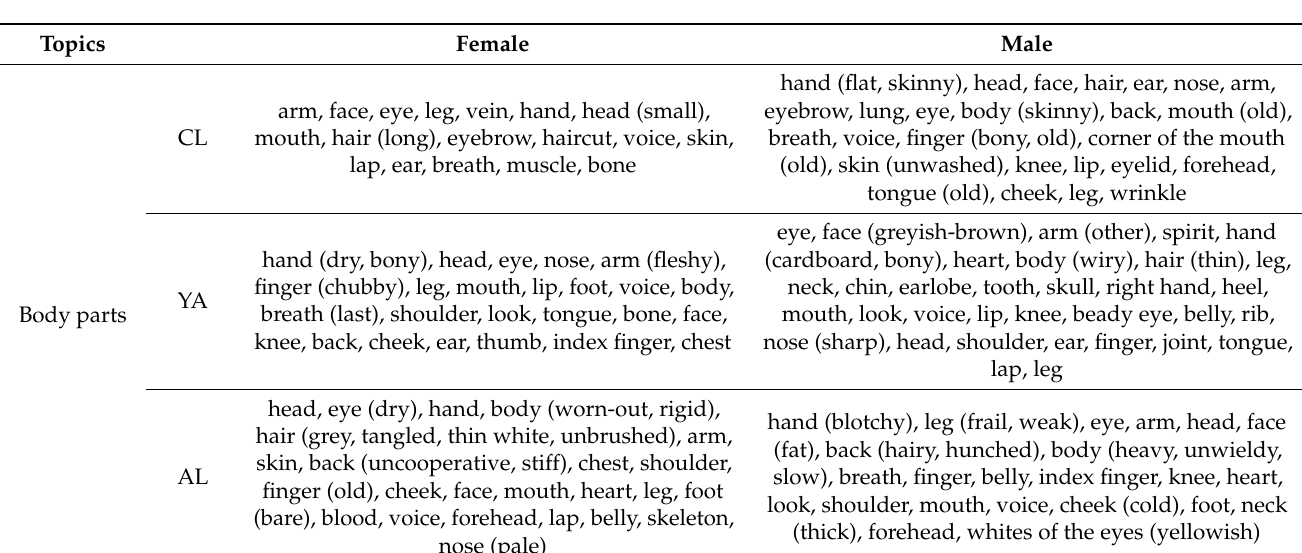
Table A3. Word lists of possessions associated with female and male older adult characters